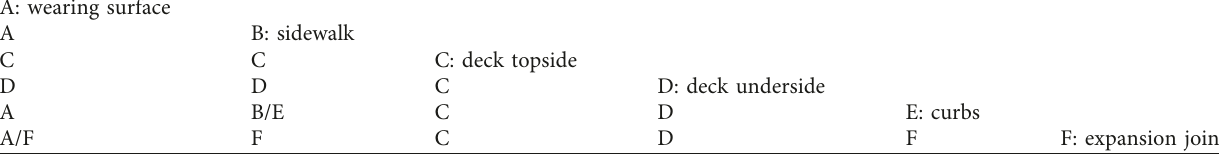
Table 3: Paired comparisons for the bridge deck subelements provided by a bridge engineer.